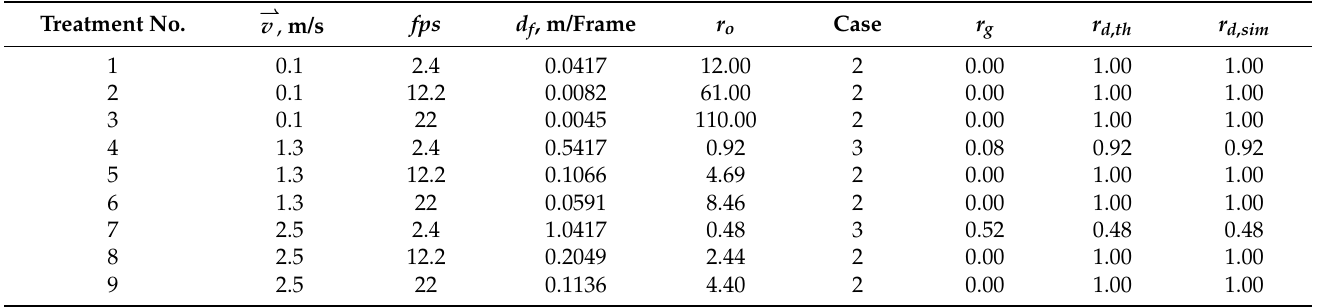
Table 5. Theoretical and simulation performance of a vision system for plant detection at S = 0.5 m (cid:42) v ) and inferencing speed ( f ps ). at three-levels of travel velocity ( Treatment